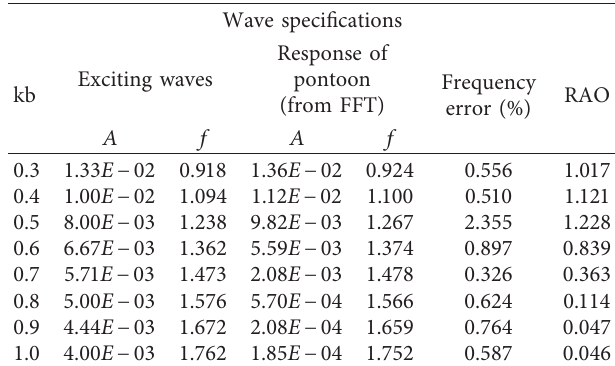
Figure 12: Schematics of the submerged breakwater and heaving pontoon. Table 6: The heaving pontoon dimensions. Table 9: Amplitude and frequency of the heaving pontoon for breakwater number